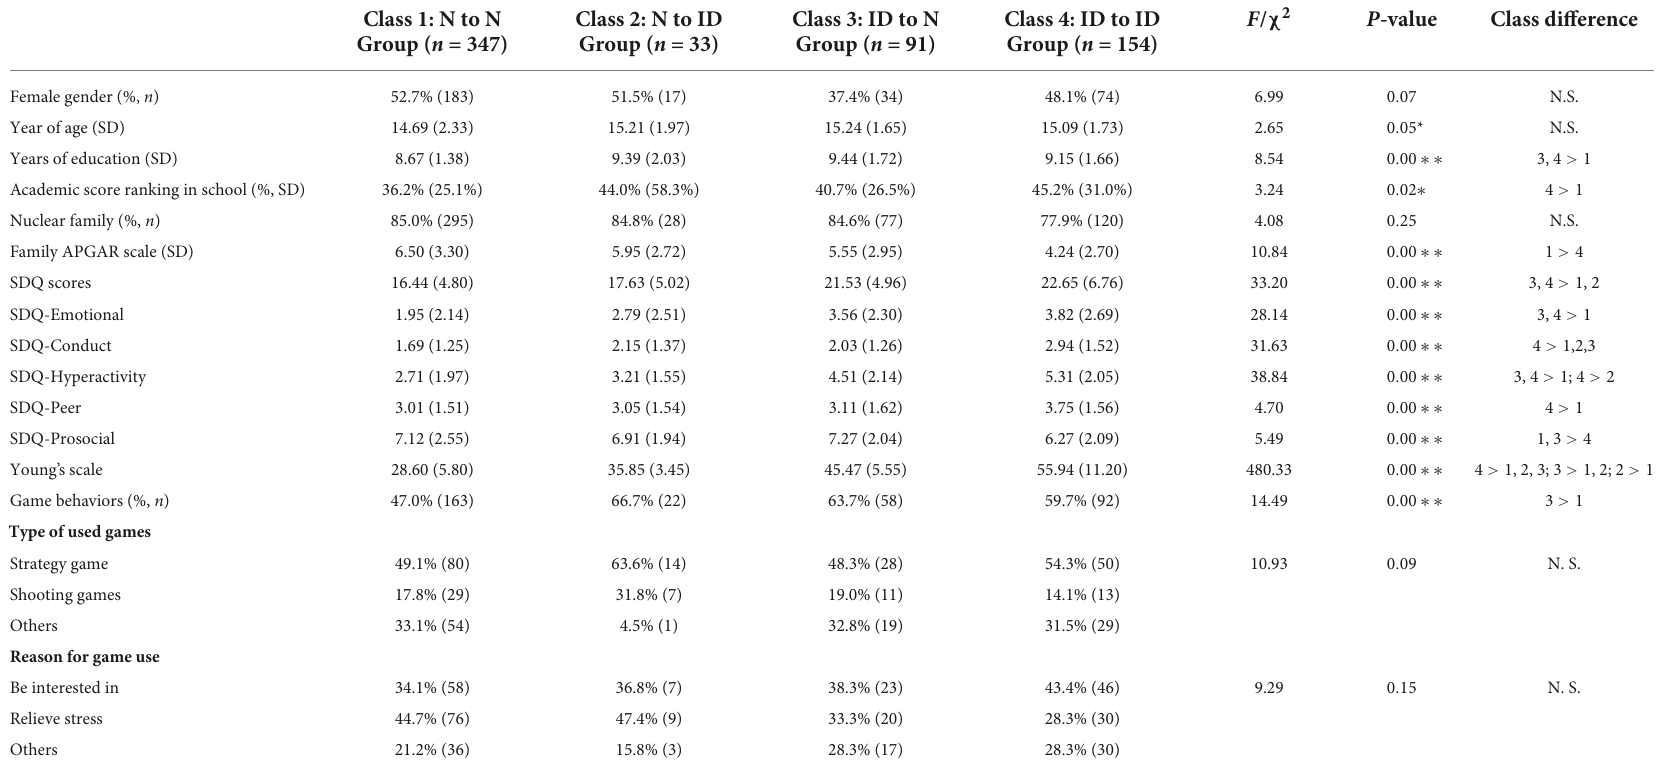
TABLE 2 The demographic and clinical characteristics of adolescents in different Internet behavior changing